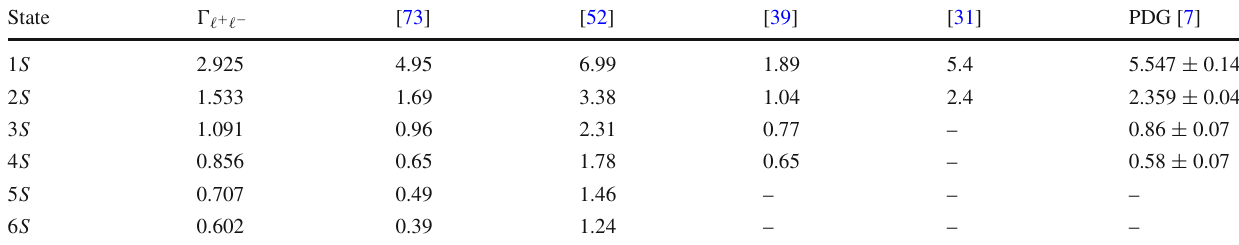
Table 18 Dilepton decay width of charmonia (in keV) State